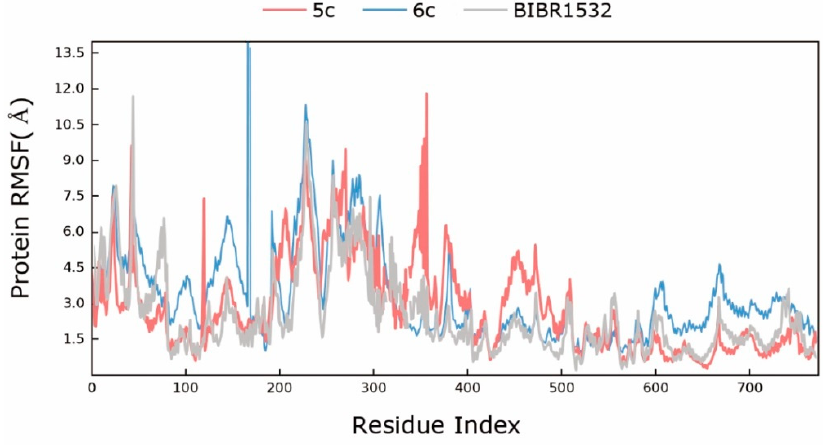
Figure 4. The root-mean-square fluctuation (RMSD) curve of BIBR1532/telomerase (gray), 5c /telomerase (pink) and 6c /telomerase (blue) complexes.